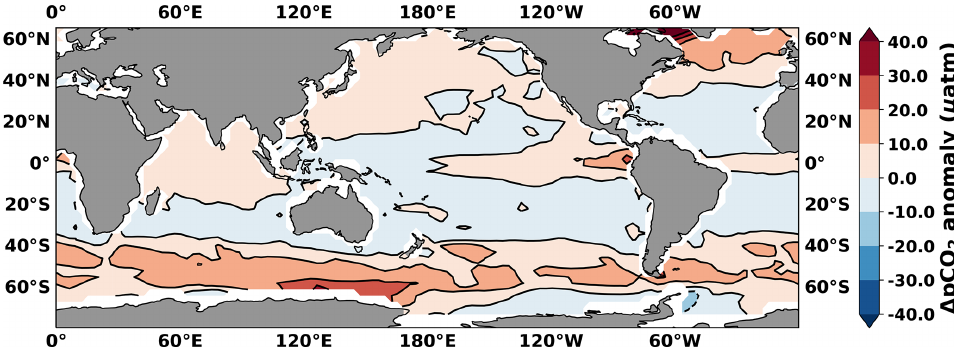
Figure 6. Changes in the air–sea p CO 2 gradient (15ka minus 17.2ka) simulated by